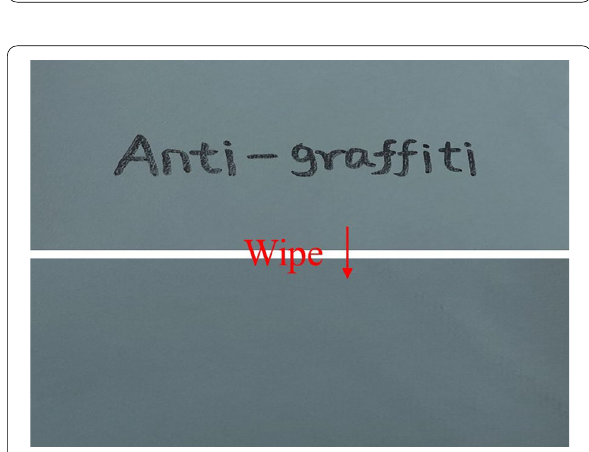
Fig. 8 Test results of anti-fouling performance of PDMS synthetic leather